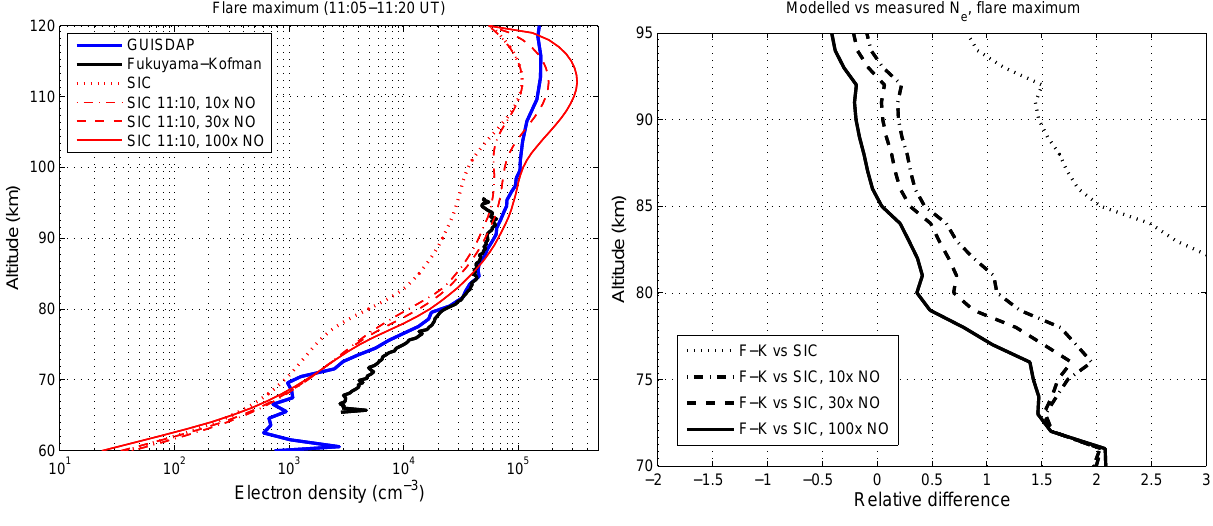
Fig. 5. The 28 October 2003 X17 flare event. Left plot: SIC and EISCAT results at the peak of the flare. GUISDAP profiles are averaged over the period 11:05–11:20UT. The F-K MCMC fit was applied to data averaged over the same interval. In the model runs the hard X-rays based on the spectra fitted to GOES data were switched on at 10:50 UT. Results shown are for 11:10. Right plot (N.B: altitudes restricted to 70–95km): Relative differences between F-K MCMC and SIC electron densities, (N e ( F-K ) − N e ( SIC ))/N e ( F-K ) .